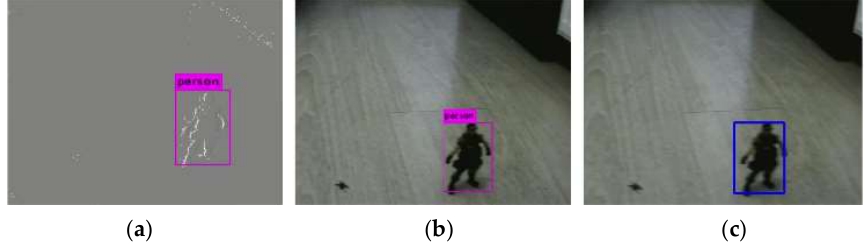
Figure 13. Results of combined detection (event frame: detected, standard frame: detected). ( a ) Event frame-based detection, ( b ) Standard frame-based detection, ( c ) Combined detection.